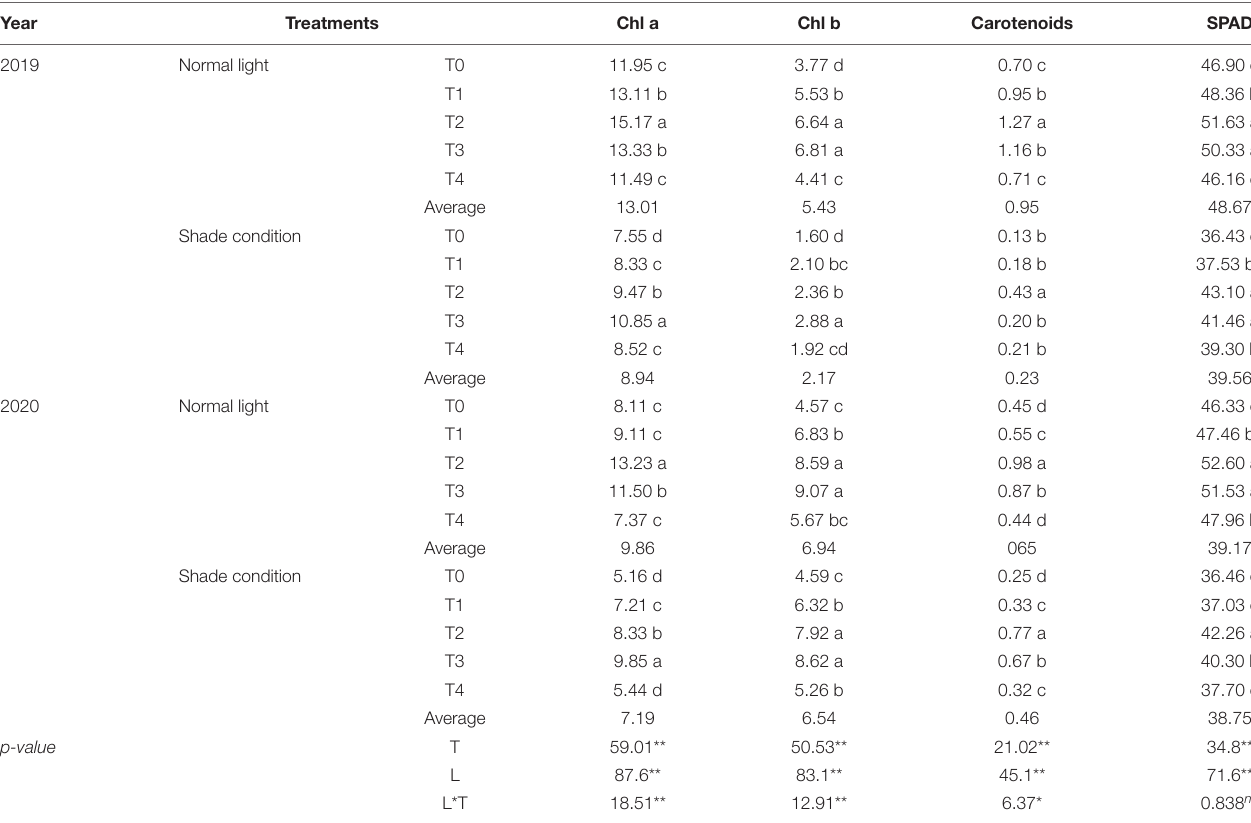
TABLE 2 | Effect varied NH 4 + /NO 3 − ratios on the chlorophyll pigments under different light